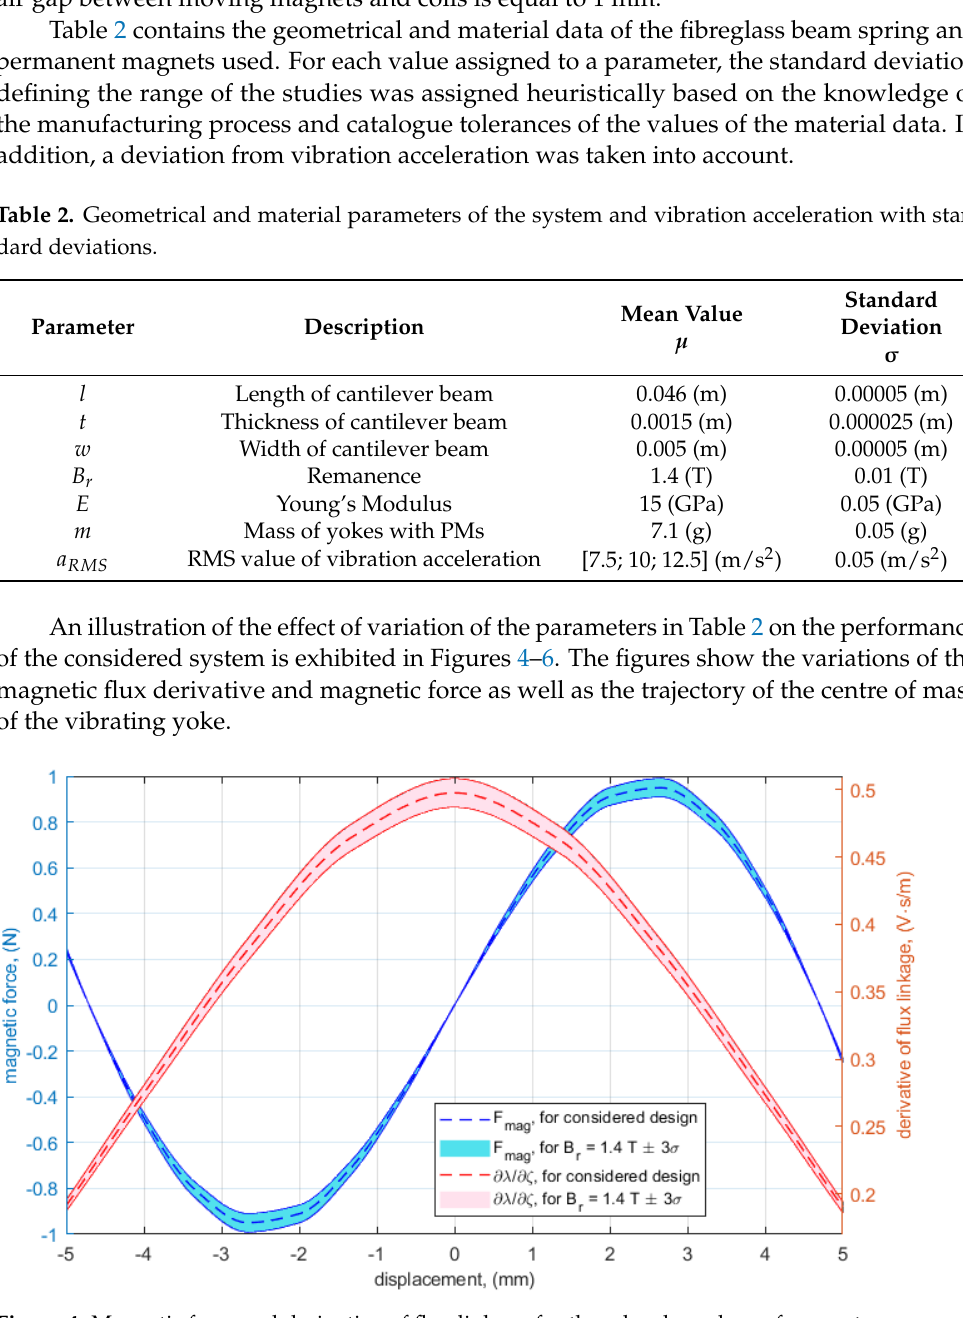
Figure 4. Magnetic force and derivative of flux linkage for three border values of magnet remanence.